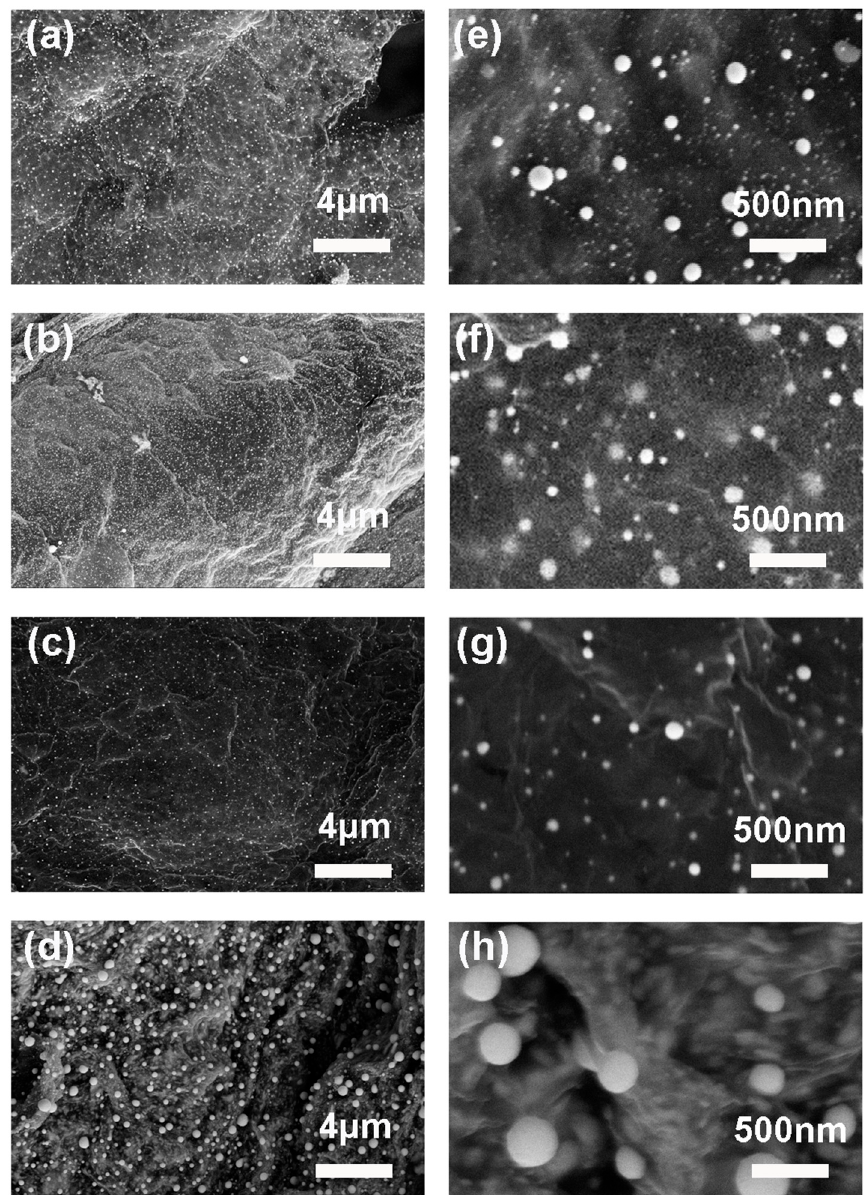
Figure 4. SEM images of the ( a , e ) Pd; ( b , f ) Pt; ( c , g ) Ni; and ( d , h ) Sn nanoparticles loaded aerogels formed after hydrogen reduction.